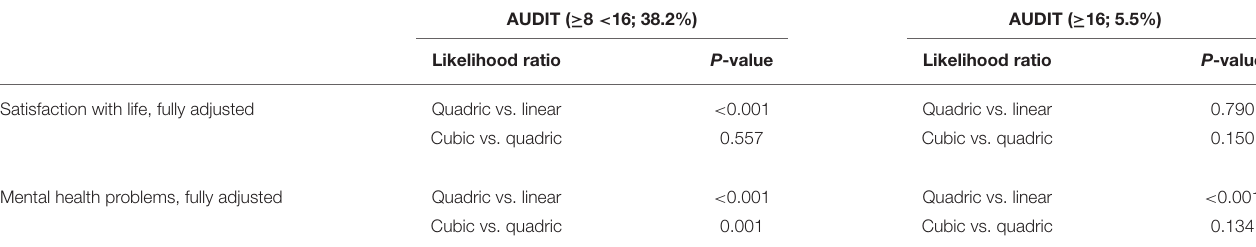
TABLE 5 | Likelihood-ratio tests for the associations between satisfaction with life, mental health problems and potential alcohol-related problems.